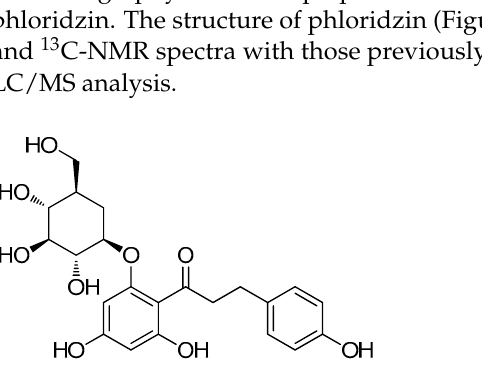
Figure 1. The chemical structure of